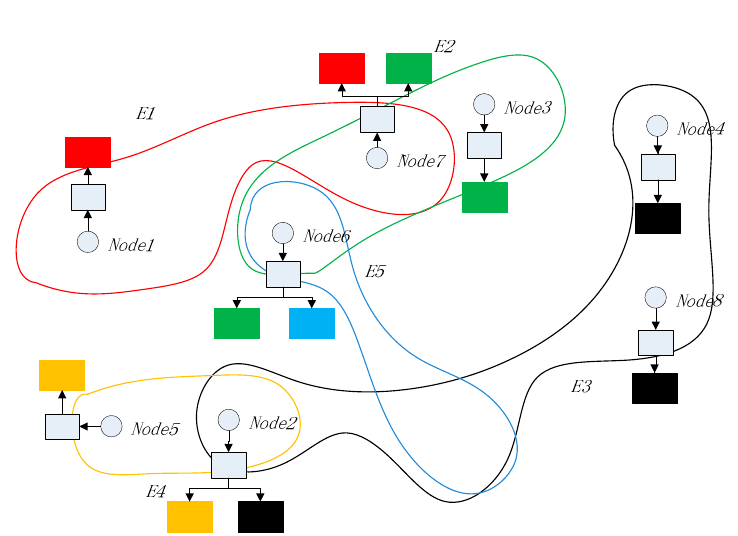
Figure 4. The data structure of node blocks.